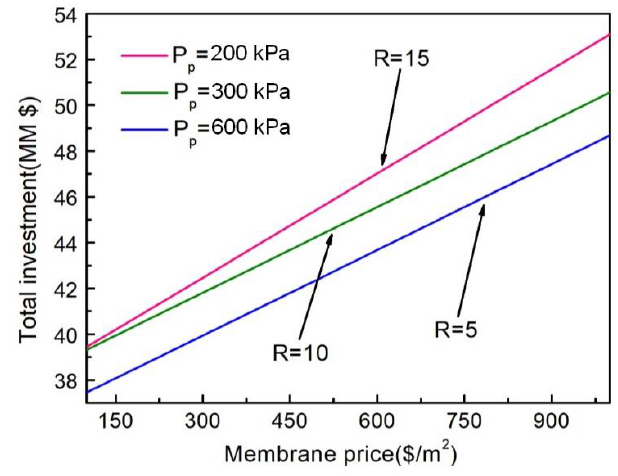
Figure 8. Impact of membrane price on total investment cost under different pressure ratios.